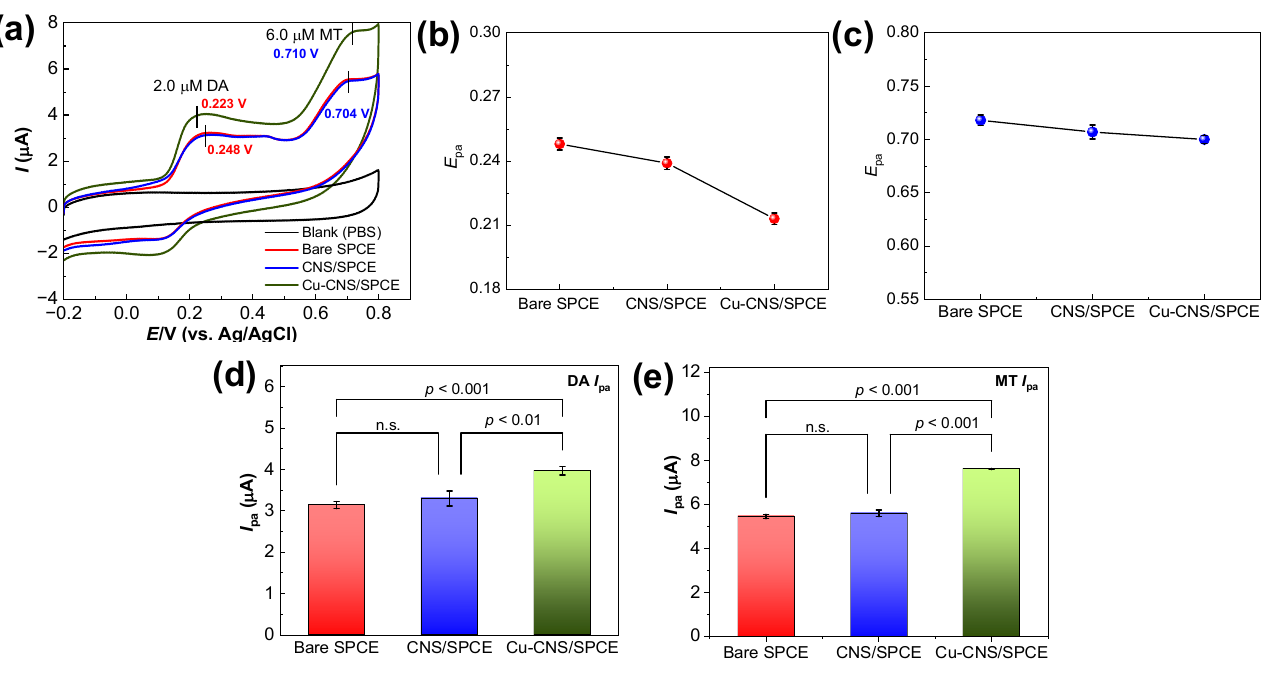
Figure 5. ( a ) CV responses of Cu–CNS/SPCE in 0.1 M phosphate buffer solution, pH 7.0, containing 2.0 µ M DA and 6.0 µ M MT. The corresponding E pa plots of ( b ) DA and ( c ) MT, and I pa values plots for ( d ) DA and ( e ) MT. The bar charts represent the mean ± s.d. (n = 3). A highly significant increase in current response ( p < 0.001), a significant increase ( p < 0.01), and no significant difference (n.s.; p > 0.05).